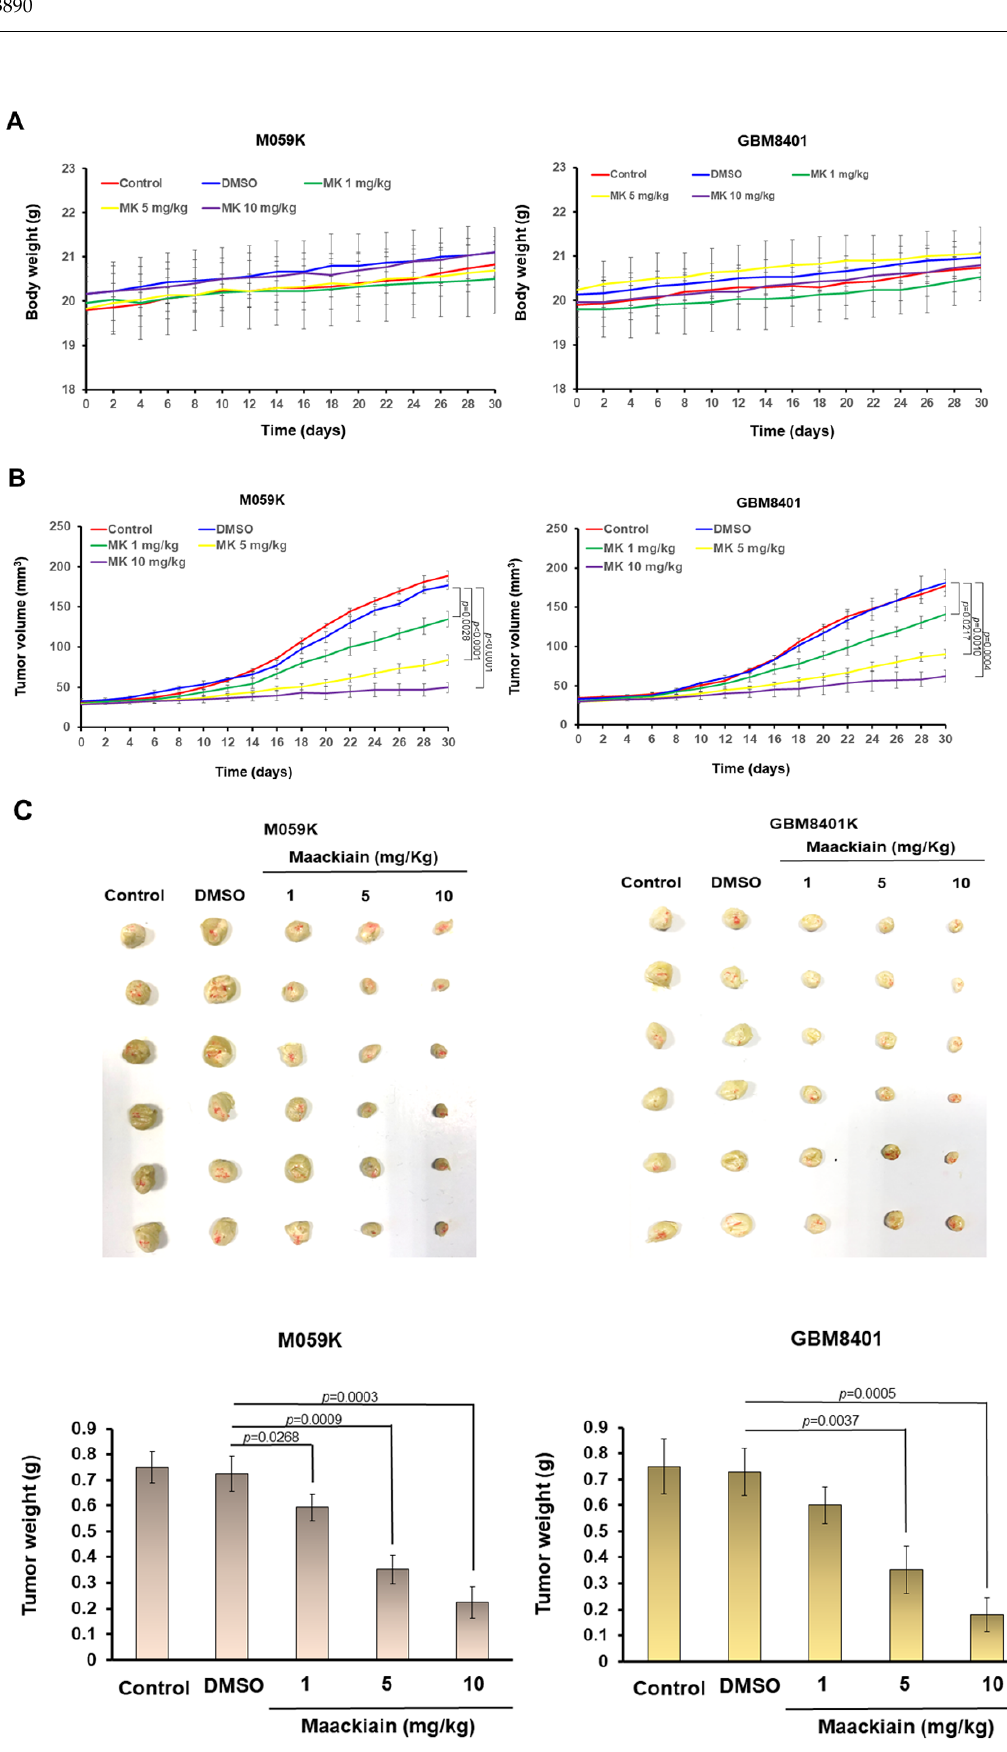
Figure 9. Maackiain (MK) has a significant antitumor effect in an immunodeficient mouse tumor model of a dorsal back subcutaneous xenograft. M059K or GBM8401 cells were inoculated subcuta- neously on the dorsal back of male BALB/c nude mice for tumor growth. Mice were randomly as- signed (n = 6 for each group) to receive five different regimens: normal saline, DMSO, 1 mg/kg MK, 5 mg/kg MK, and 10 mg/kg MK. Treatments were administered intraperitoneally on days 10, 13, and 16. ( A ) Mouse body weight was monitored at 2-day intervals continuously. There was no sig- nificant change in body weight overall. ( B ) Tumor volumes were measured every other day to ob- tain the tumor growth curves. Tumor growth was slower among MK-treated mice than in the DMSO group, particularly in the group treated with 10 mg/kg MK. ( C ) At day 30, mice were killed under anesthesia and tumors were carefully excised. Excised tumor size was smaller among MK-treated mice. ( D ) Tumor weight was remarkably reduced in the MK-treated group compared with the con- trol (normal saline) and DMSO groups in mice injected with M059K and GBM8401 cells, respectively. ( E ) The survival median of mice was evaluated for the five treatment groups until day 94. Median survival was significantly prolonged in MK-treated tumor-bearing mice compared with controls.